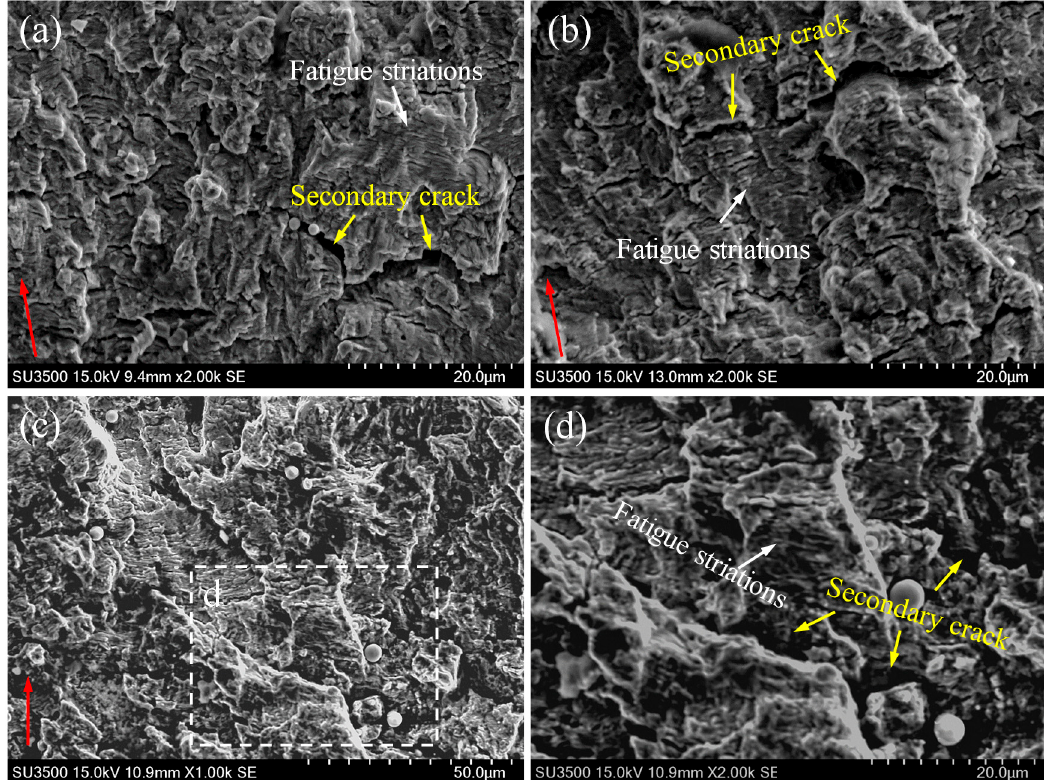
Figure 4. Fatigue fracture surfaces of ( a ) BM, ( b ) HAZ and ( c , d ) WM specimens at Δ K value of approximately 28.5 MPa · m 1/2 . Typically, the red arrows represent the crack growth direction, the white arrows represent the fatigue striations, and the yellow arrows indicate the secondary cracks.